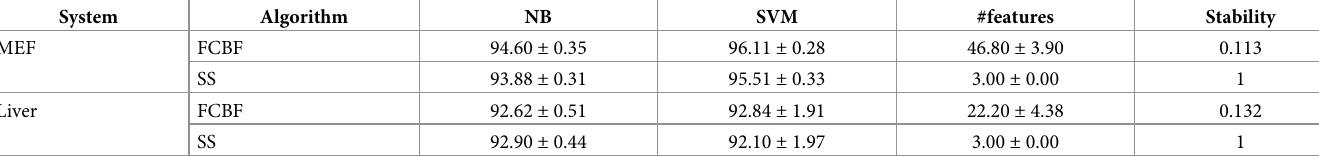
Table 3. Performance of SVM and NB classifiers using the features selected by FCBF and SS